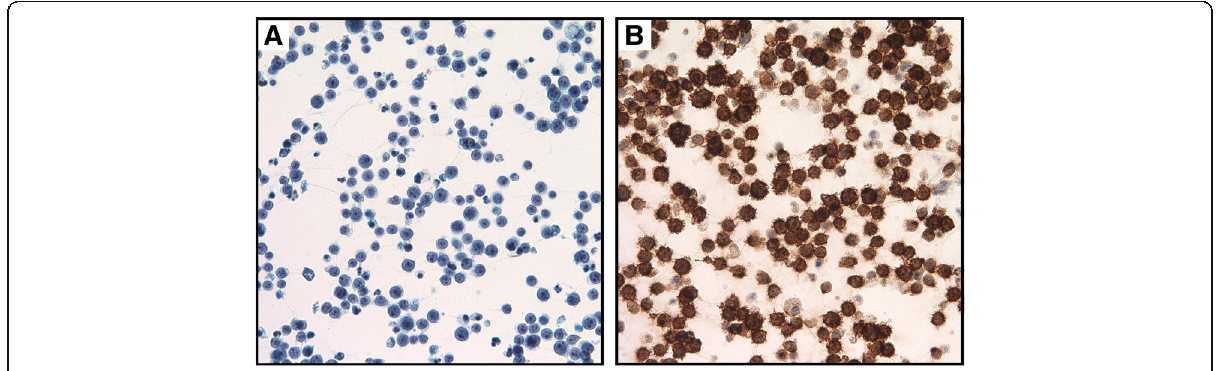
Fig. 5 Pathology slides of vitreous biopsy taken from pars plana vitrectomy. Pathology specimens with Papanicolaou stain × 600 ( a ) and CD20 stain × 600 ( b ) demonstrating numerous atypical large CD20-positive lymphocytes with variably prominent nucleoli consistent with vitreoretinal large B cell